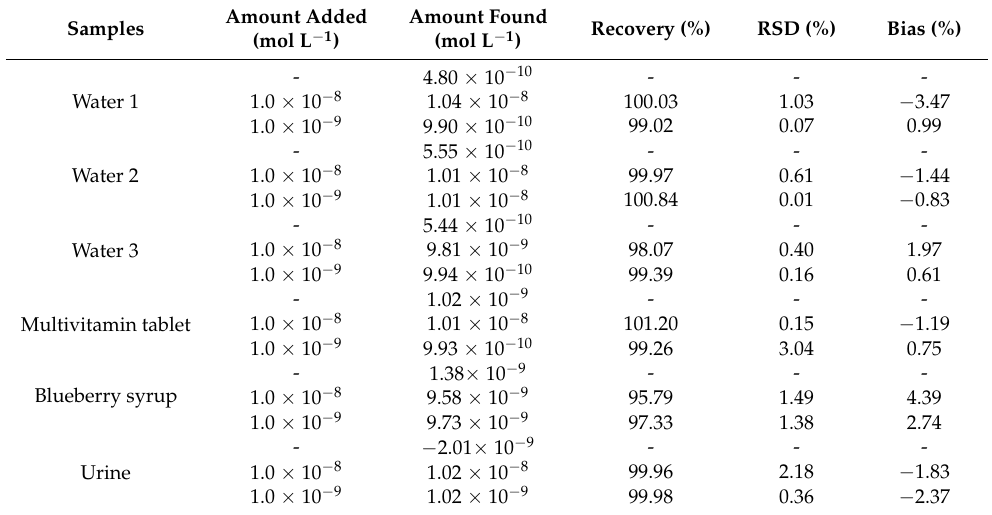
Table 4. Determination of thiamine in food and biological samples using the PIX/AuNPsnGr sensor. Samples